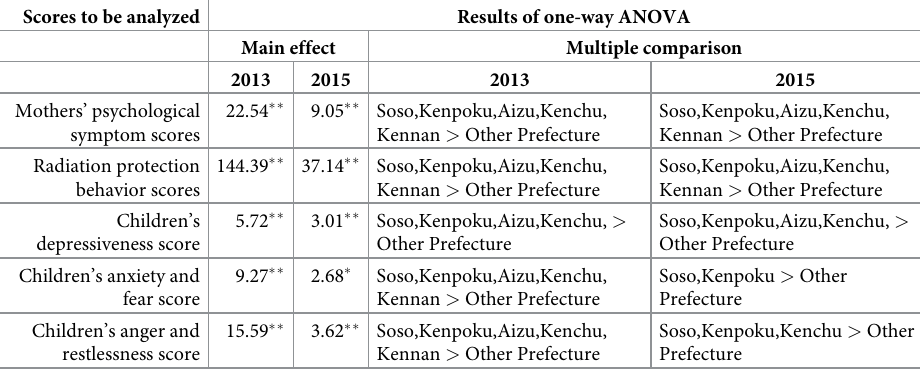
Table 5. Comparison Between the Five Regions in Fukushima Prefecture and Other Prefectures Group Scores to be analyzed Results of one-way ANOVA Main effect